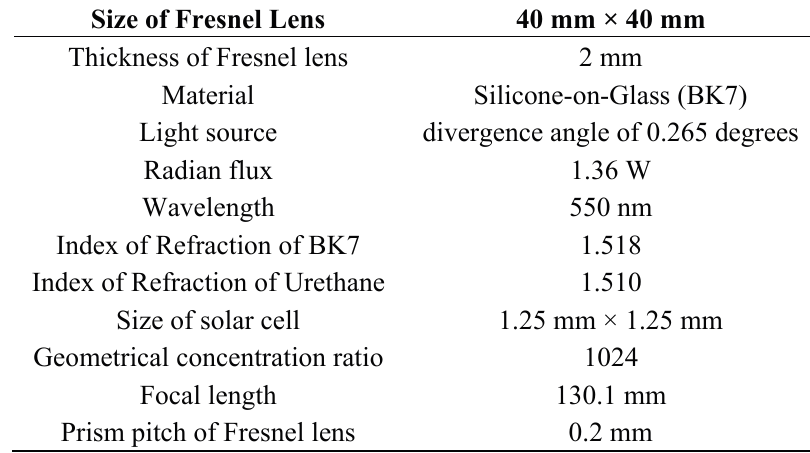
Table 1. Design parameters of the concentrated photovoltaic (CPV) unit with a flat Fresnel lens.